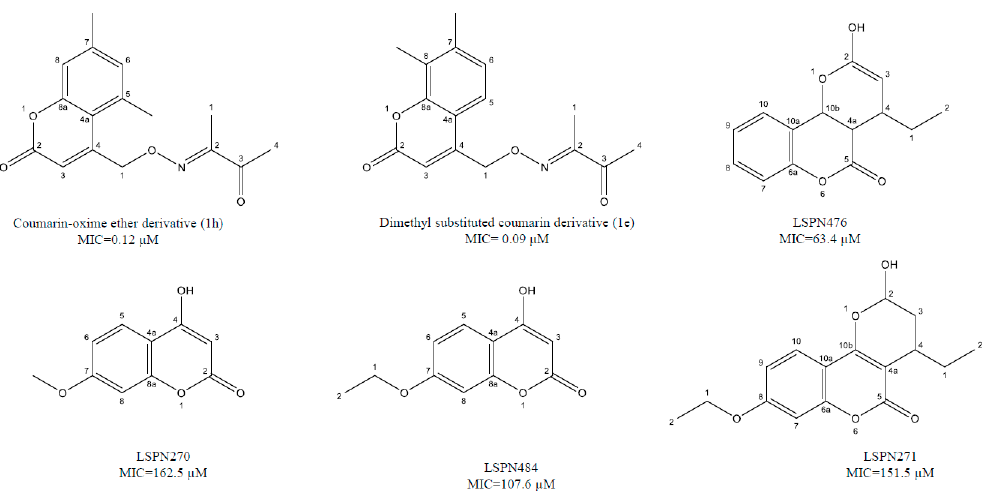
Figure 1. Chemical structure of lead isoniazid, coumarin and griselimycin derivatives with minimum inhibitory concentrations (MICs) value.